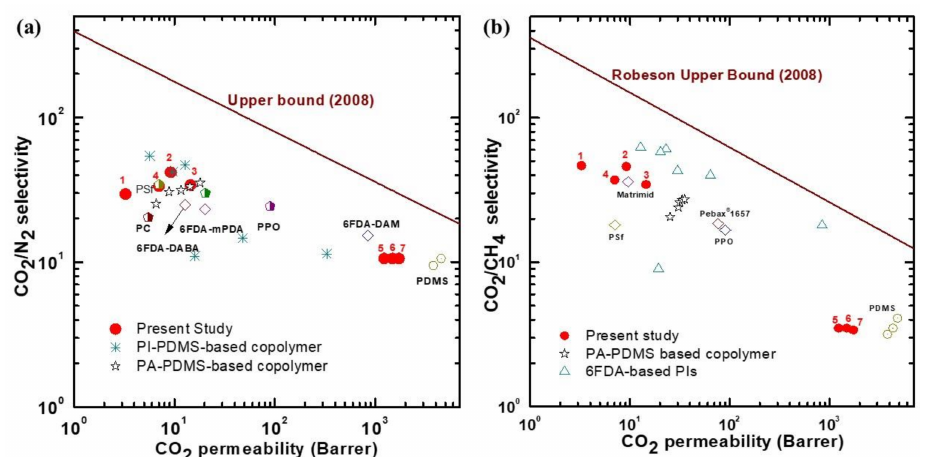
Figure 8. Robeson upper bound (2008) plot comparing the ( a ) CO 2 /N 2 and ( b ) CO 2 /CH 4 separation performance of the CE-PDMS-x copolymer membranes; the numbers 1, 2, 3, 4, 5, 6, and 7 correspond to the data points for the copolymers used in this study: 6FDA-CE-PI, CE-PDMS-2.5, CE-PDMS-5, CE-PDMS-10, CE-PDMS-20, CE-PDMS-30, and CE-PDMS-40, respectively; other data reported